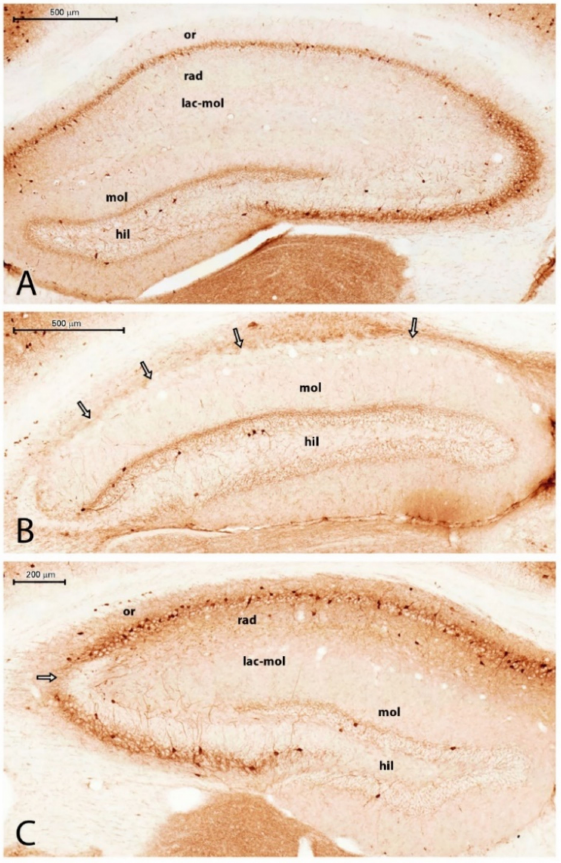
Figure 5. PV staining of the control ( A ) and epileptic ( B , C ) hippocampi. Note the scattered PV- stained neurons and pericellular PV-stained axonal network in the layers of the principal neurons in ( A ) (or = stratum oriens; rad = stratum radiatum; lac-mol = stratum lacunosum-moleculare; mol = molecular layer of DG; hil = hilum of DG; bar = 500 µ m). ( B ) In animal PT7, there were no principal neurons in CA1–3, and the PV neurons disappeared, too (arrows point to the location of the stratum pyramidale without cells). Bar = 500 µ m; mol = molecular layer of DG; hil = hilum of DG. ( C ) Patchy neuronal loss in CA3 (arrow). Abbreviations are the same as in ( A , B ); bar = 200 µ